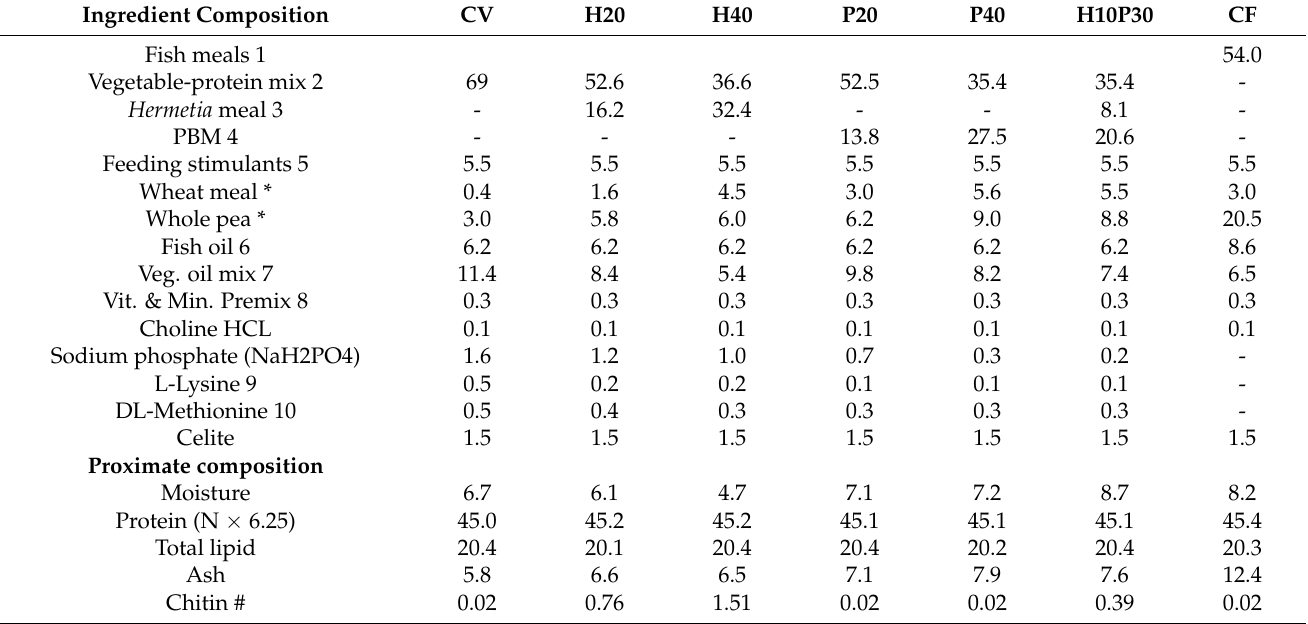
Table 1. Ingredient (g 100 g − 1 ) and proximate (% as fed) composition of the test